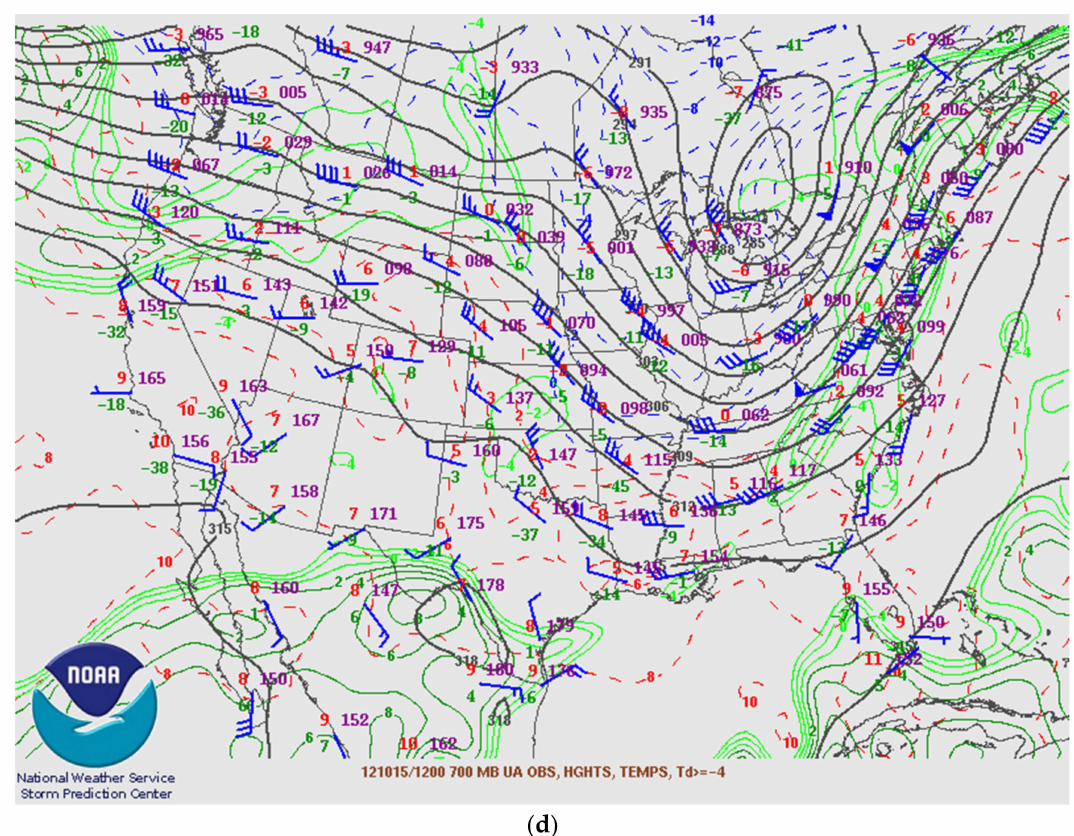
Figure 5. ( a ) Upper-level 700 hPa analysis charts for 10-14-0000 UTC. ( b ) Upper-level 700 hPa analysis charts for 10-14-1200 UTC. ( c ) Upper-level 700 hPa analysis charts for 10-15-0000 UTC. ( d ) Upper-level 700 hPa analysis charts for 10-15-1200 UTC. Graphics from